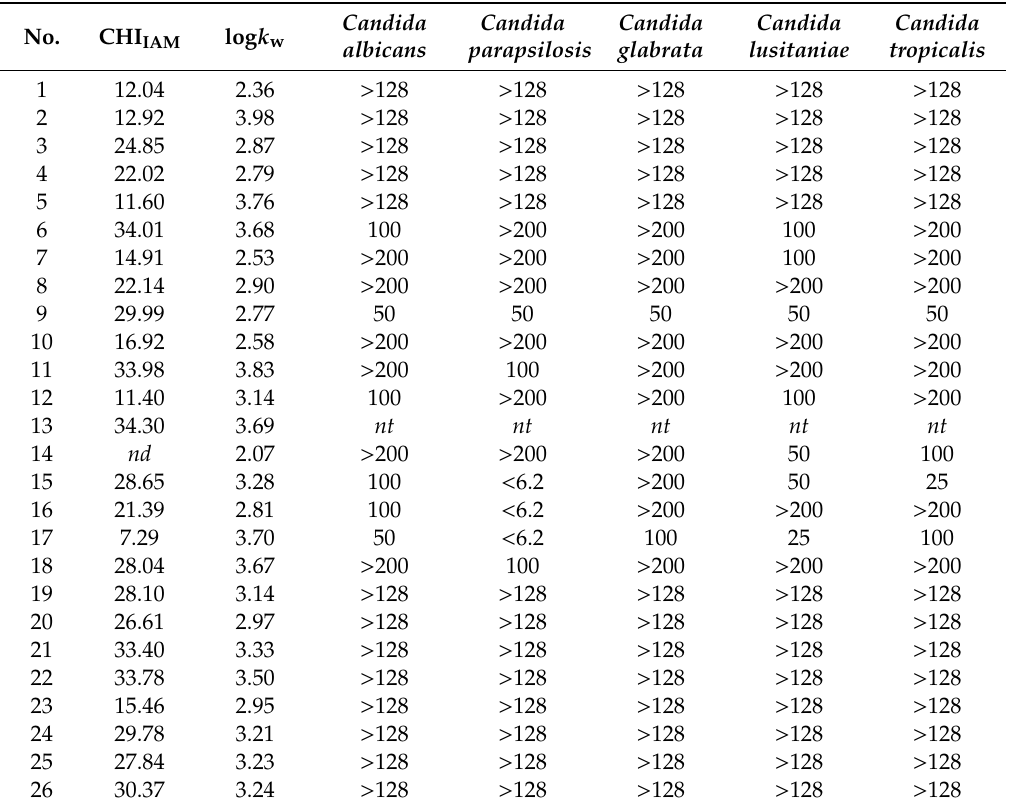
Table 1. Chromatographically determined CHI IAM and log k w parameters [23], accompanied by MIC values against Candida species